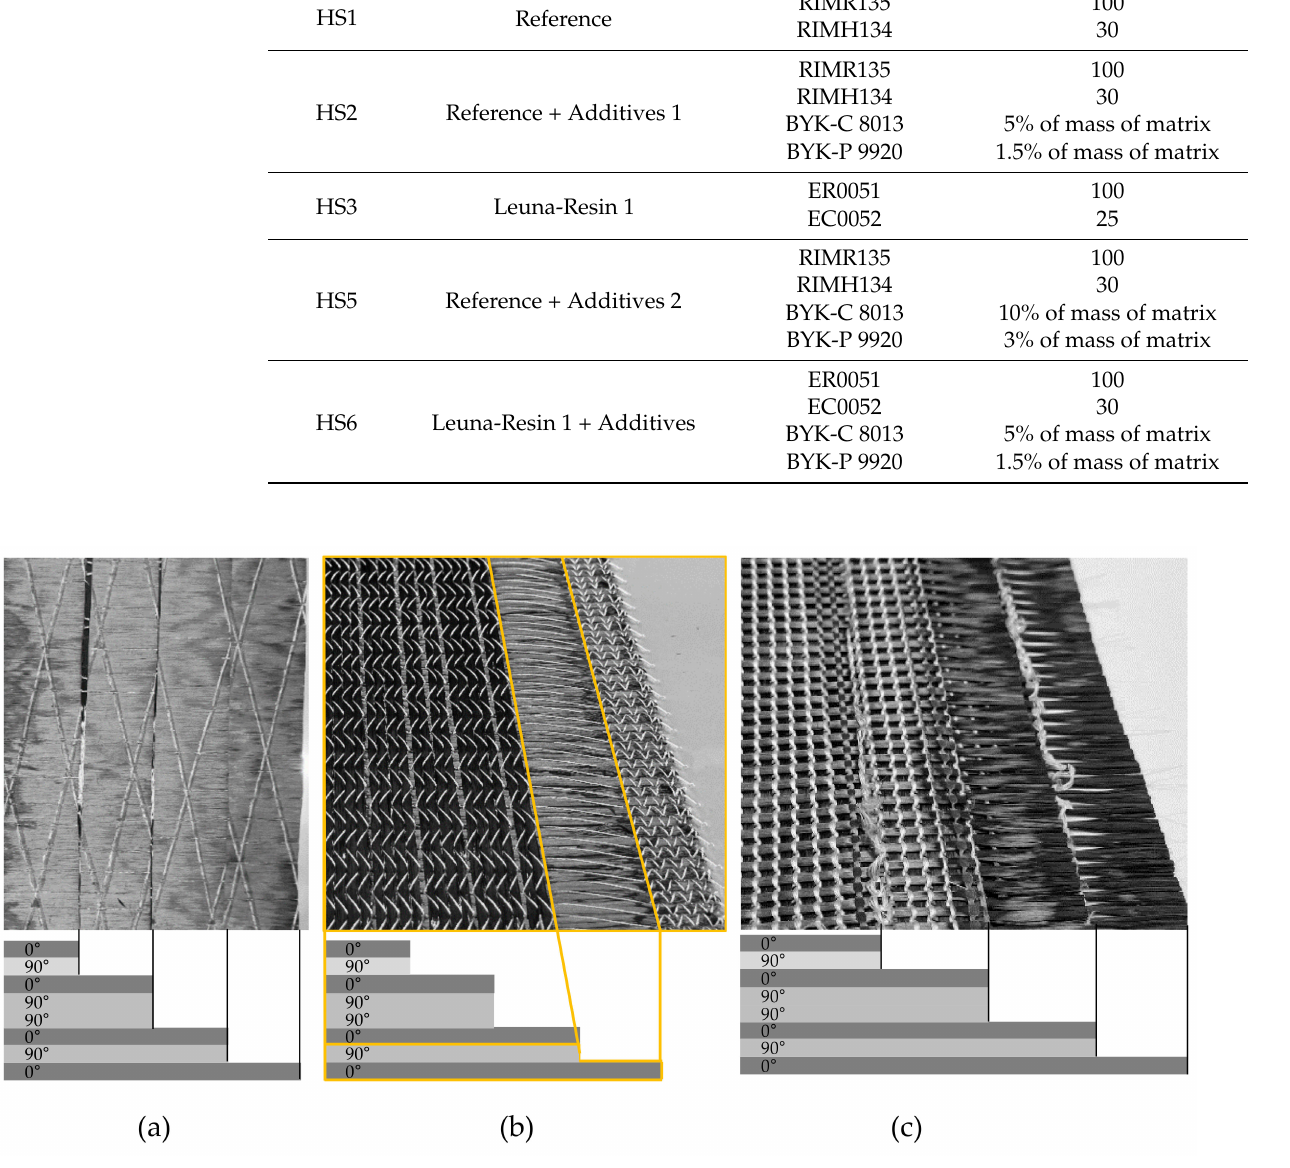
Figure 1. Manufactured repair patches, right half shown, with stacking sequence below: ( a ) full stacked UD patch, ( b ) one part of the full biaxial reinforced two-layered TFP-patch (yellow marked layers of the full patch) and ( c ) stacked, biaxial, reinforced MLG-patch that consist of four double layered patch